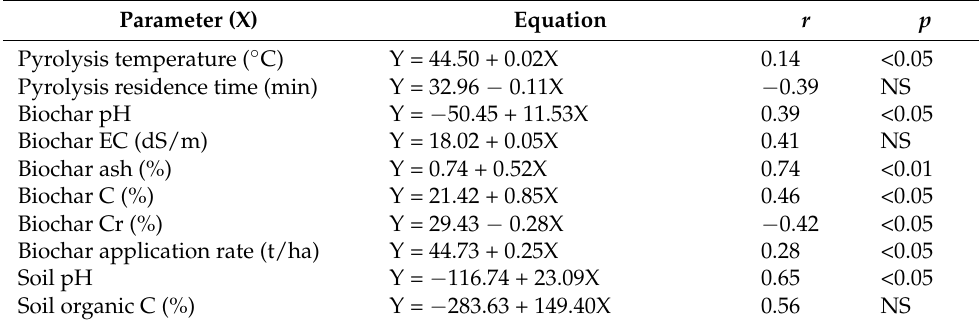
Table 5. Exponential relationships between Cr immobilization efficiency (Y) and biochar production conditions, biochar properties, and soil properties (X), developed through exponential regression